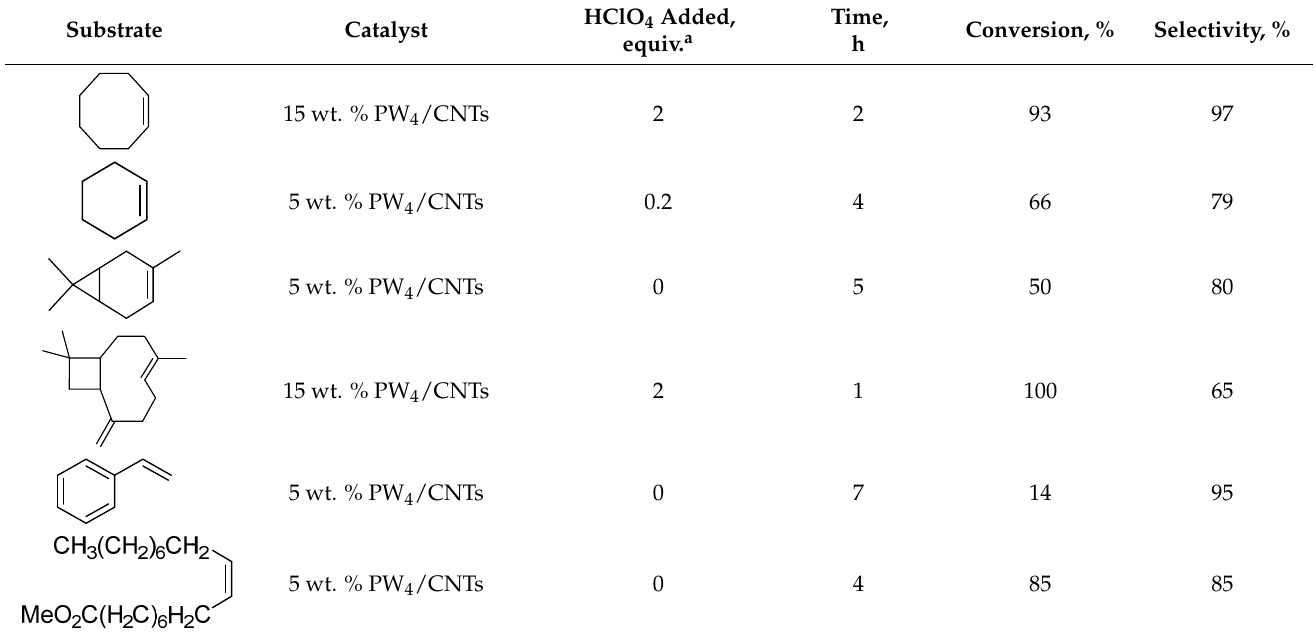
Table 4. Catalytic oxidation of various alkenes with H 2 O 2 over PW 4 /CNTs catalysts. Substrate Catalyst